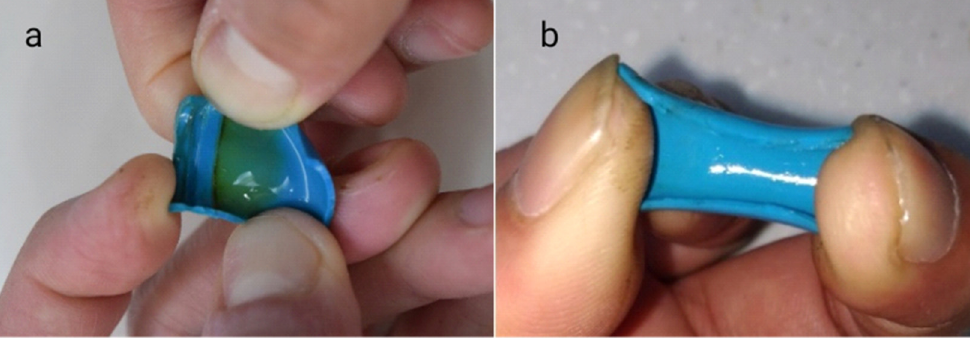
Figure 8. The ACD is added to RO water to clean the pipeline of the ACD dental chair. ( a ). The section of the pipeline before use is filled with biofilm. ( b ). The section of the pipeline after use has no biofilm.